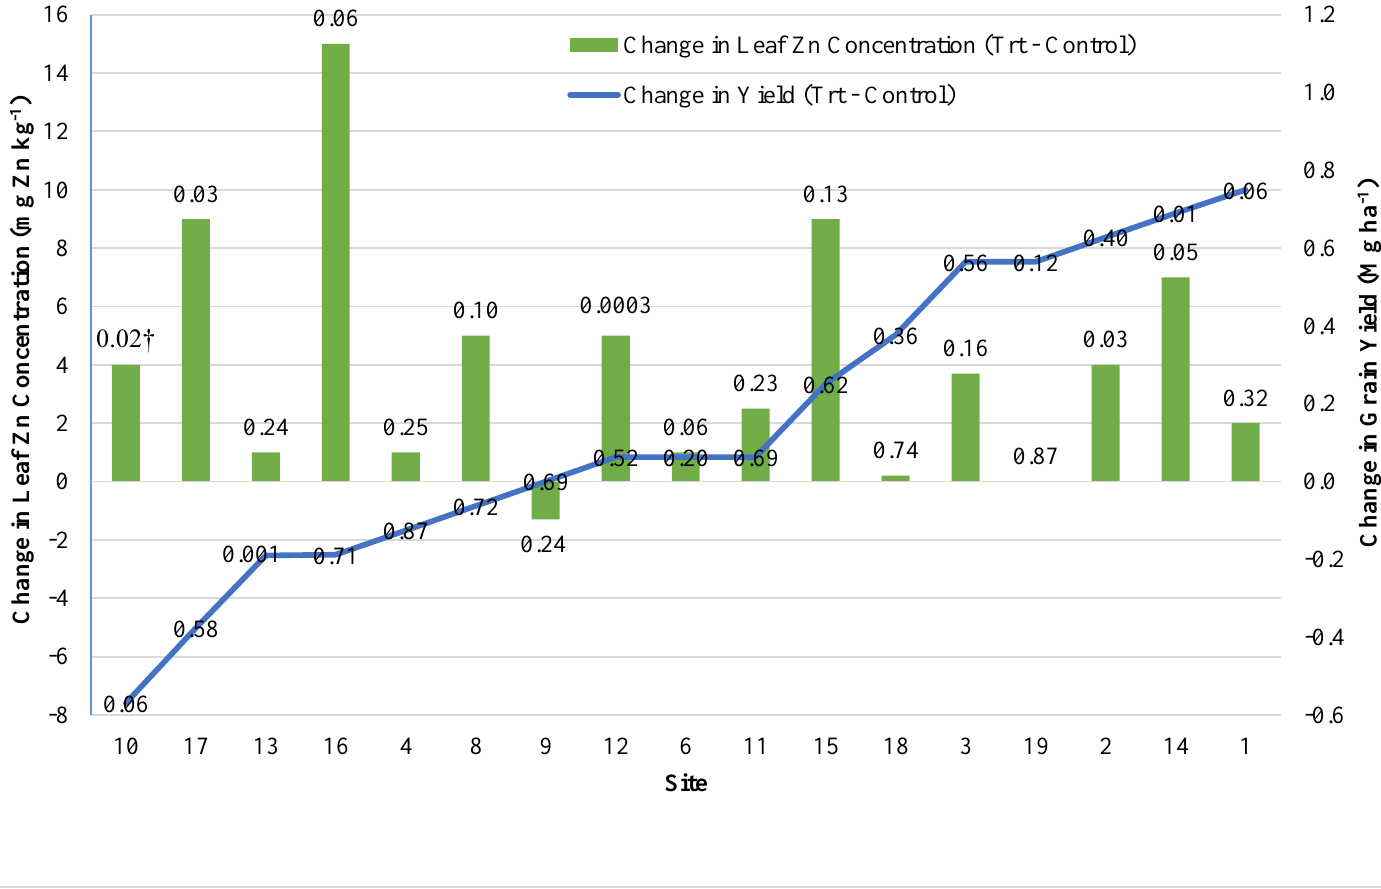
Figure 4. Leaf Zn concentration (bars) and maize grain yield (line) responses to foliar Zn application for 17 sites. Data labels on both the line and bar graphs indicate p -values † for mean comparison differences. The correlation coefficient (r) for the relationship of changes in tissue Zn concentration and grain yield due to foliar Zn application is 0.2.